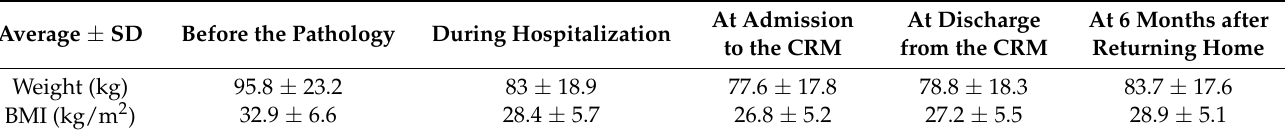
Table 3. Weight and BMI variations during the patient’s follow-up.